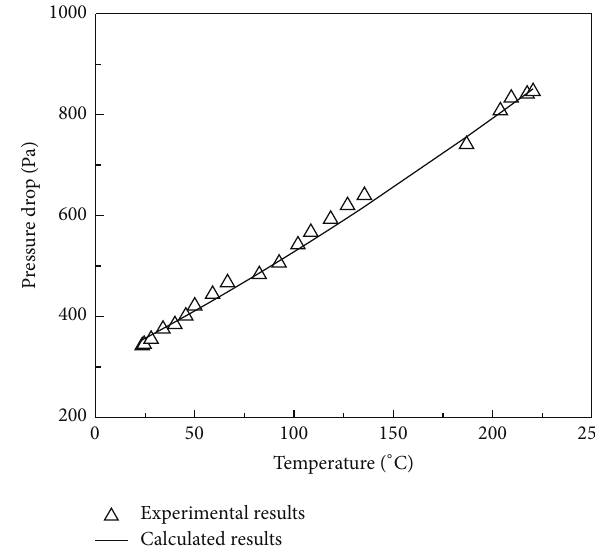
Figure 8: Resistance proportion distribution with different catalytic oxidation bed average temperatures.